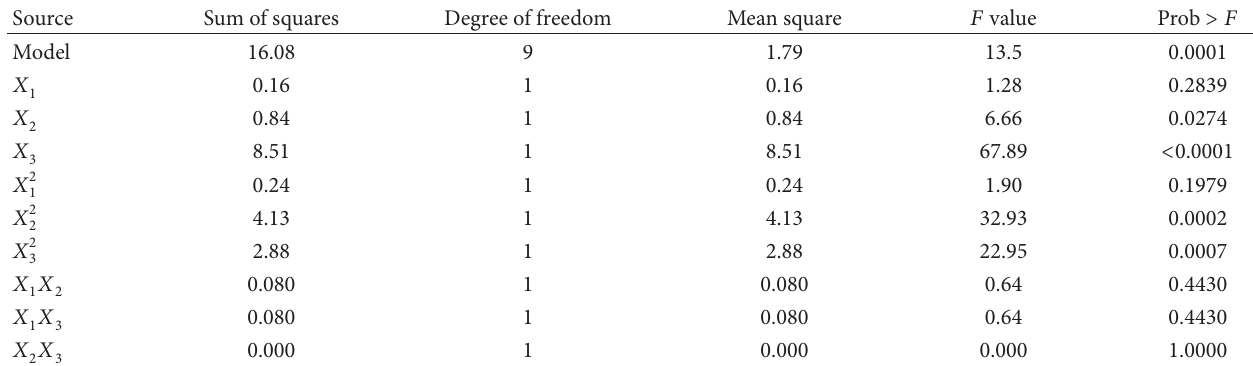
T 1: ANOVA for response surface quadratic model for BPAC yield.